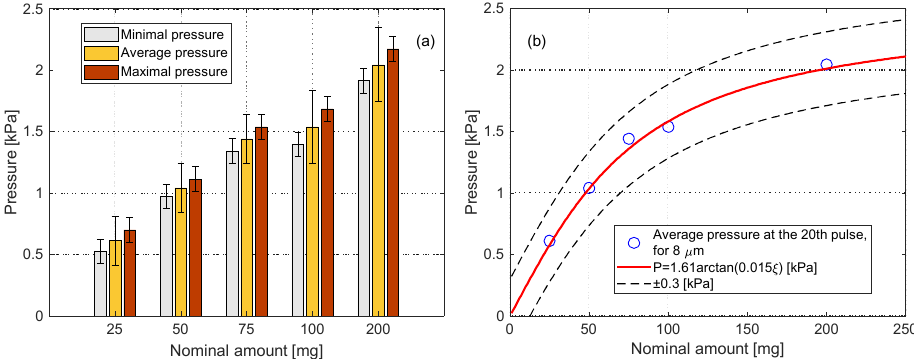
Figure 12. Results of the maximum pressure difference at the 20th pulse, for different amounts. ( a )—Min, Average and Max of each set of measurements. ( b )—The average of each set of measurements, with a correlation.